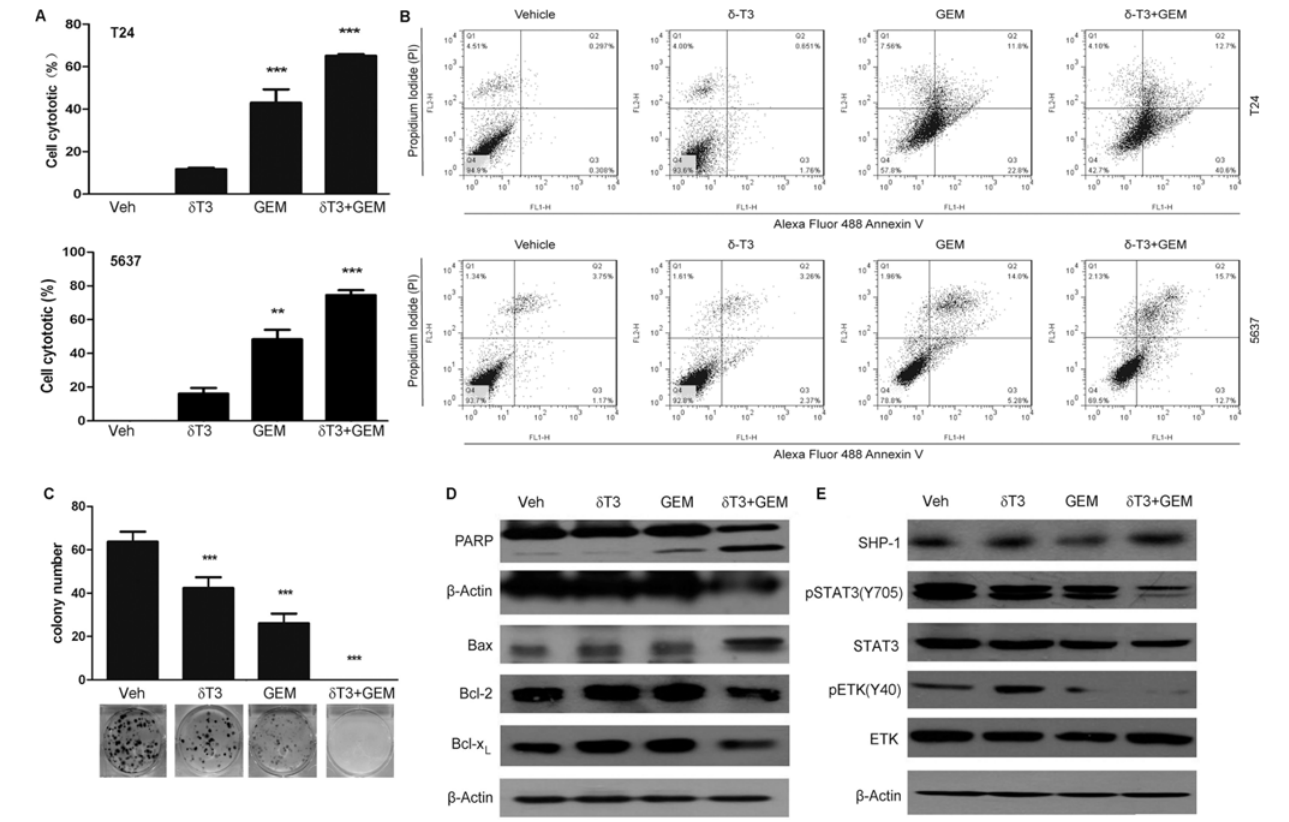
Fig 6. Low concentration of δ -T3 enhanced the anti-cancer effects of Gemcitabine (GEM) on bladder cancer cell growth. (A) T24 and 5637 cells were incubated for 48 h in the presence of 25 μ M δ -T3 and/or 0.08 μ M GEM. Then, the percentage of cell viability was determined by MTT assay. (B) T24 and 5637 cells were cultured for 48 h in the absence or presence of 25 μ M δ -T3 and/or 0.08 μ M GEM, respectively. Apoptotic rates were analyzed by Annexin V/ PI staining assay. (C) Combined treatment with GEM (0.08 μ M) and δ -T3 (25 μ M) for 14 days completely eliminated the colony formation capacity of T24 cells. (D) Western blotting analysis of the apoptosis-related and STAT3 signaling-related protein levels in T24 cells, treated with δ -T3 and/or GEM for 48 h. (E) Western blotting analysis of the STAT3 signaling-related protein levels in T24 cells, treated with δ -T3 and/or GEM for 24h. ** , P < 0.01; *** , P < 0.001.